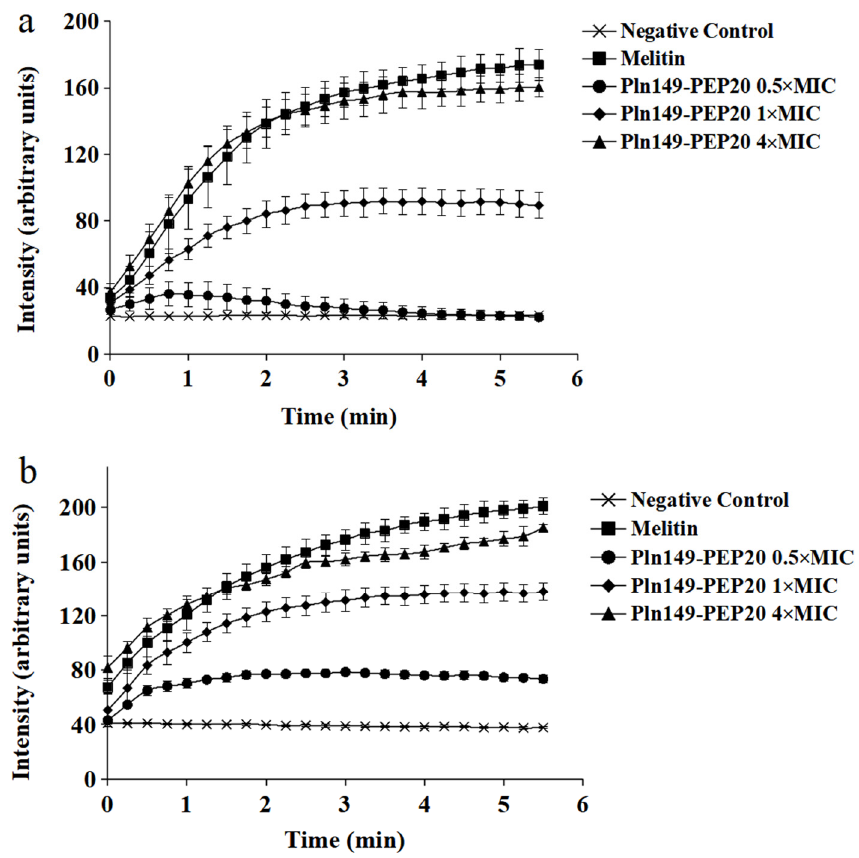
Figure 4. Pln149-PEP20 cytoplasmic membrane depolarization for ( a ) S. aureus ATCC 25923 (MIC = 8 mg/L). ( b ) A. baumannii ATCC 19606 (MIC = 32 mg/L).